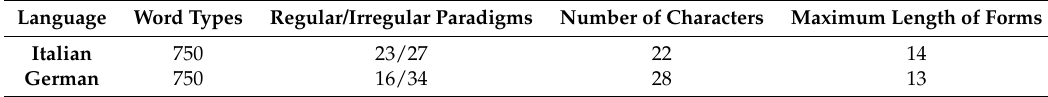
Table 1. The Italian and German